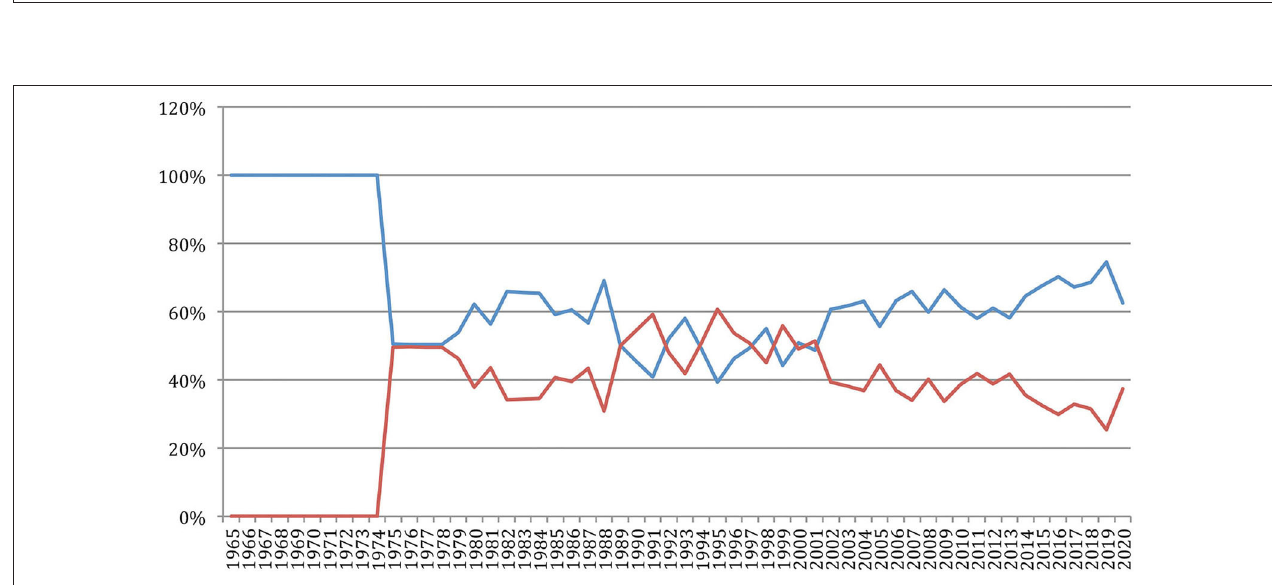
FIGURE 17 | Number of NLP (blue) vs. Speech (red) articles being cited over time.